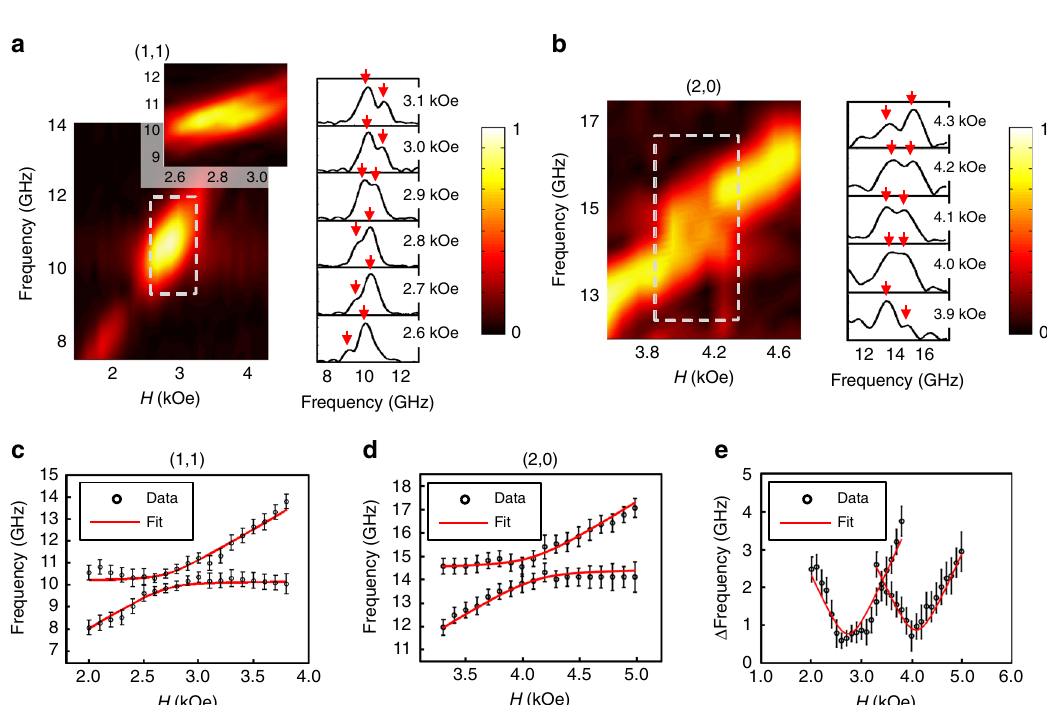
Fig. 2 Avoided crossings and fi ts. Close-ups of the Fourier amplitude spectra exhibiting anti-crossings for the ( a ) (1,1) and ( b ) (2,0) modes. The amplitudes are normalized within each fi gure. Next to each colormap are the Fourier spectra obtained from the TR-MOKE time trace for the range of applied fi elds selected by the dotted gray box in the colormap. The two peaks are indicated by the red arrows. The inset in ( a ) is the boxed region Fourier transformed over a longer time length to display the two modes more clearly. c Simultaneous fi ts (solid red lines) of Eq. (3) to the frequencies of the (1,1) and ( d ) (2,0) modes. The error in the frequencies is the FFT resolution obtained from the time duration of each frequency component in the signal. e Mode splitting energy of the (1,1) and (2,0)